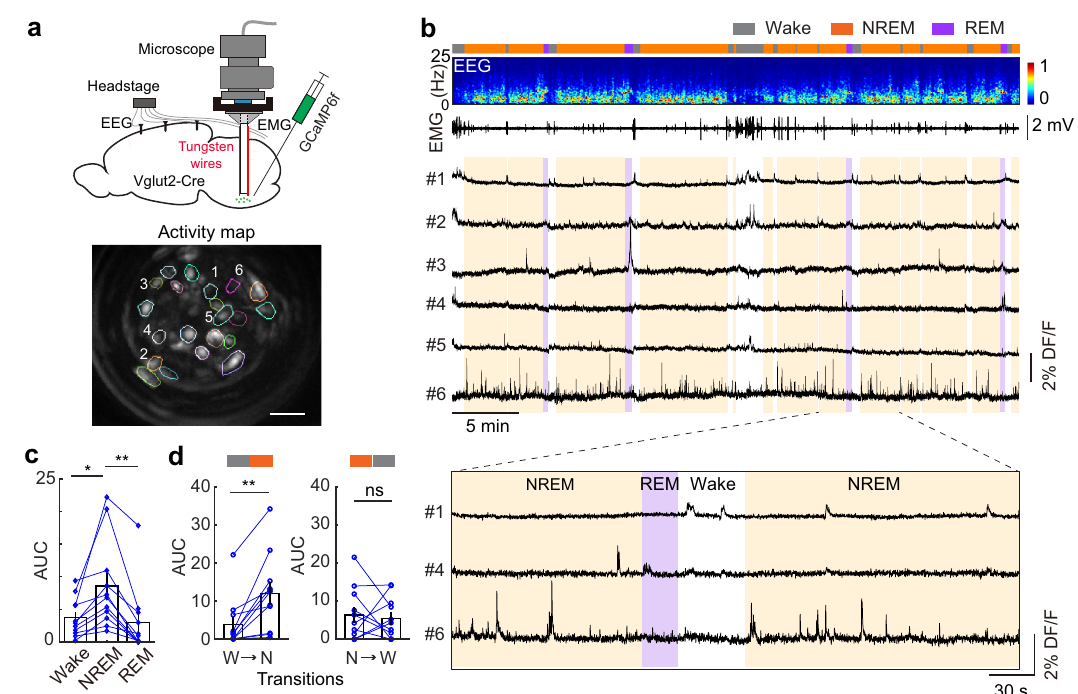
Fig. 2 | Imaging medulla glutamatergic neurons during sleep. a Schematic of microendoscopiccalciumimagingintheVLM.TungstenwiresattachedtotheGRIN lens were used to stabilize the fi eld of view. Bottom, activity map of an example imaging session in a Vglut2-Cre mouse. Scale bar, 50 μ m. b An example showing brain states (gray for wake, orange for NREM sleep, purple for REM sleep), EEG powerspectrogram(0 – 25Hz),EMG,andrepresentativecalciumtraces(DF/F)inan imaging session. Brown shadows indicate NREM sleep. Purple shadows indicate REM sleep. Bottom, enlarged window showing calcium activity in 3 cells (#6 as a NREM sleep active cell) during wake – sleep transition. c Quanti fi cation of calcium